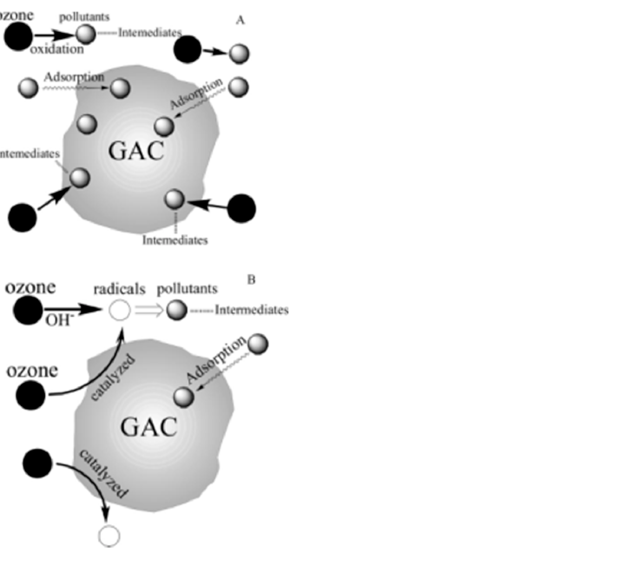
Figure 13. Sketch map of the main reaction on granular activated carbon (GAC) surface: ( A ) acidic conditions; ( B ) basic